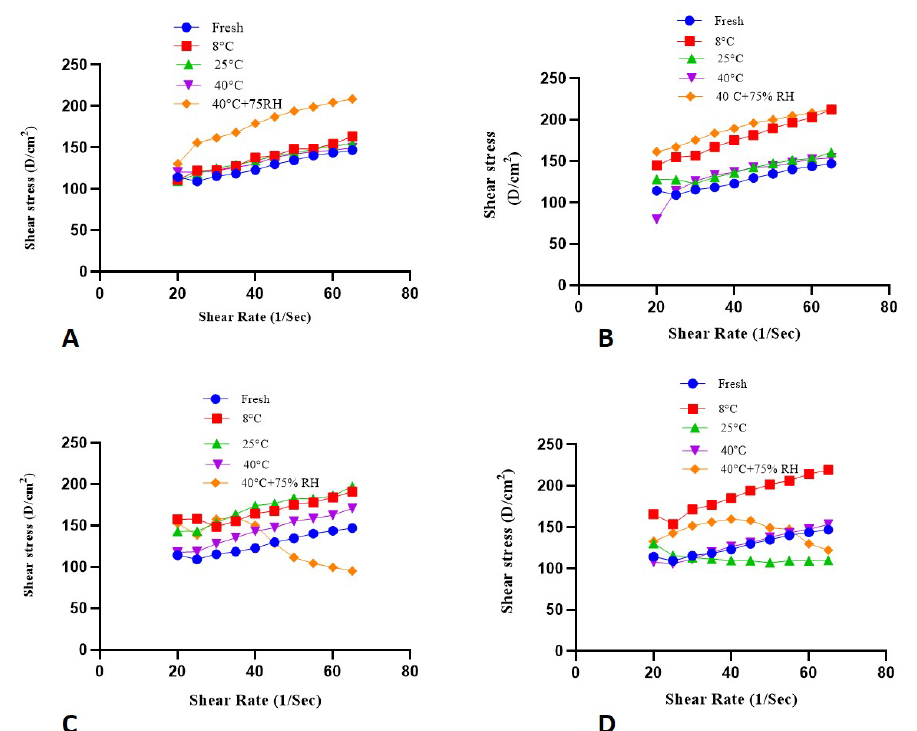
Figure 6. Rheograms of placebo kept at ( A ) (fresh), ( B ) (after 30 days), ( C ) (after 60 days), ( D ) (after 90 days).